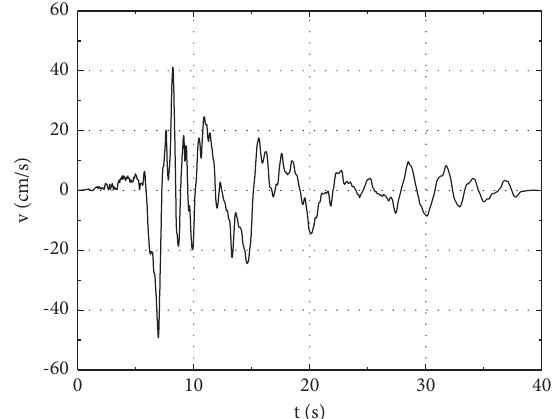
Figure 5: The synthetic velocity time